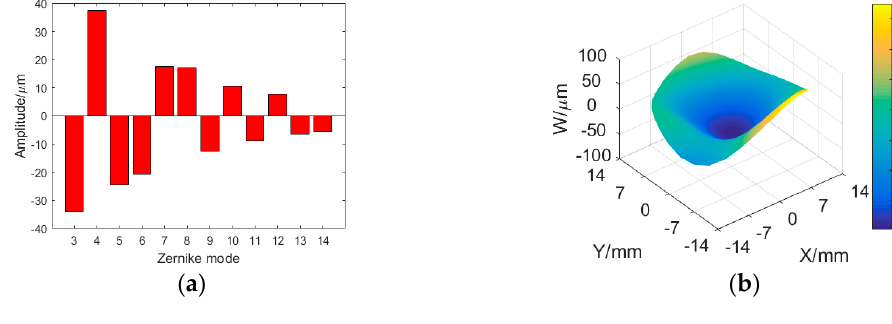
Figure 7. ( a ) The image captured by CCD with random aberration generated by the MFDM; ( b ) light intensity distribution. Figure 6. Target aberration. ( a ) Zernike mode numbers of the target aberration; ( b ) the aberration wavefront.